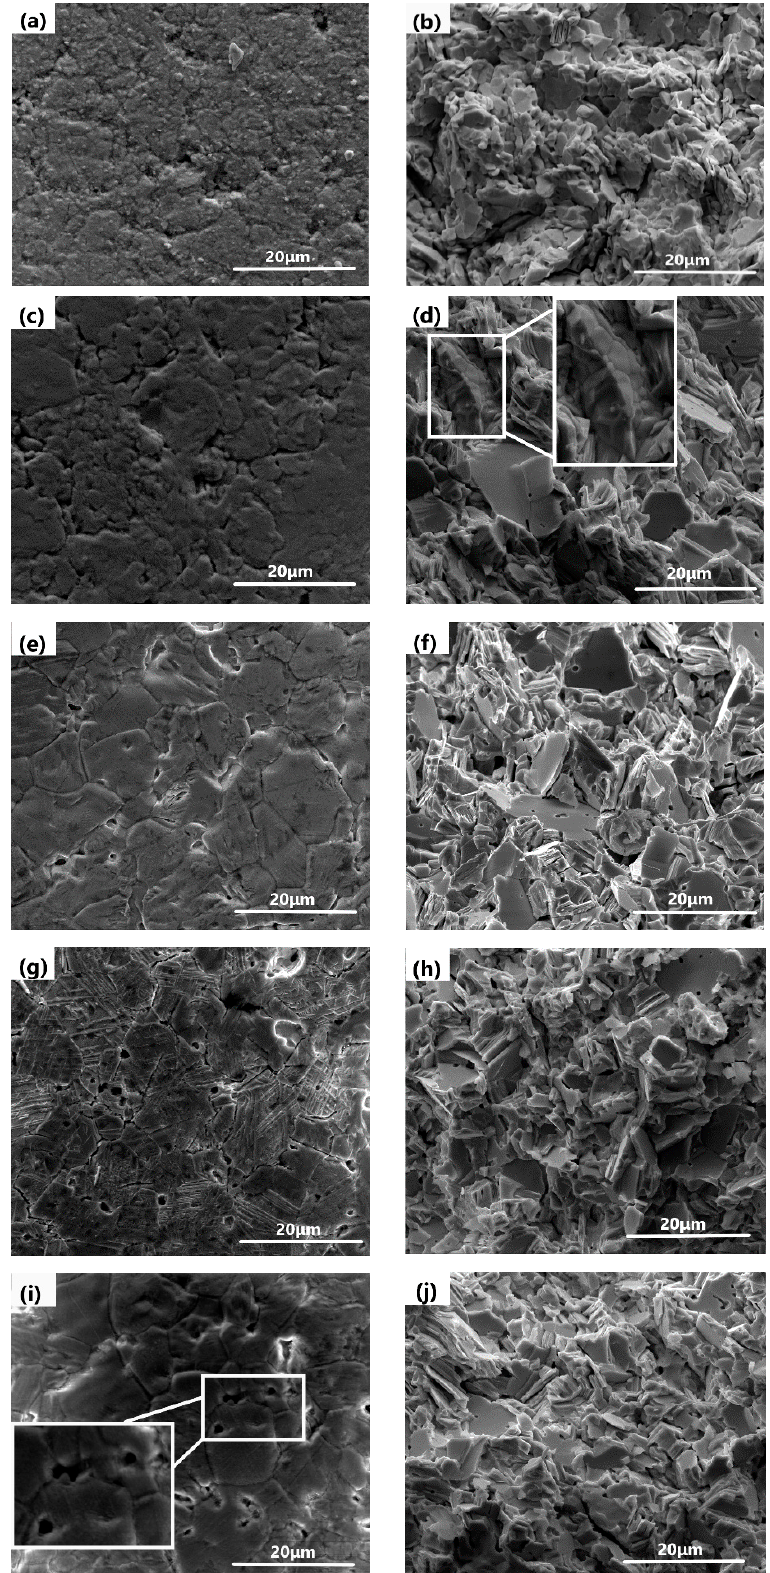
Figure 7. SEM micrograph and fracture images of PbO ceramic pellets sintered at 620 °C with different Bi 2 O 3 content: ( a , b ) 0 wt.%, ( c , d ) 1 wt.%, ( e , f ) 3 wt.%, ( g , h ) 5 wt.%, and ( i , j ) 7 wt.%.